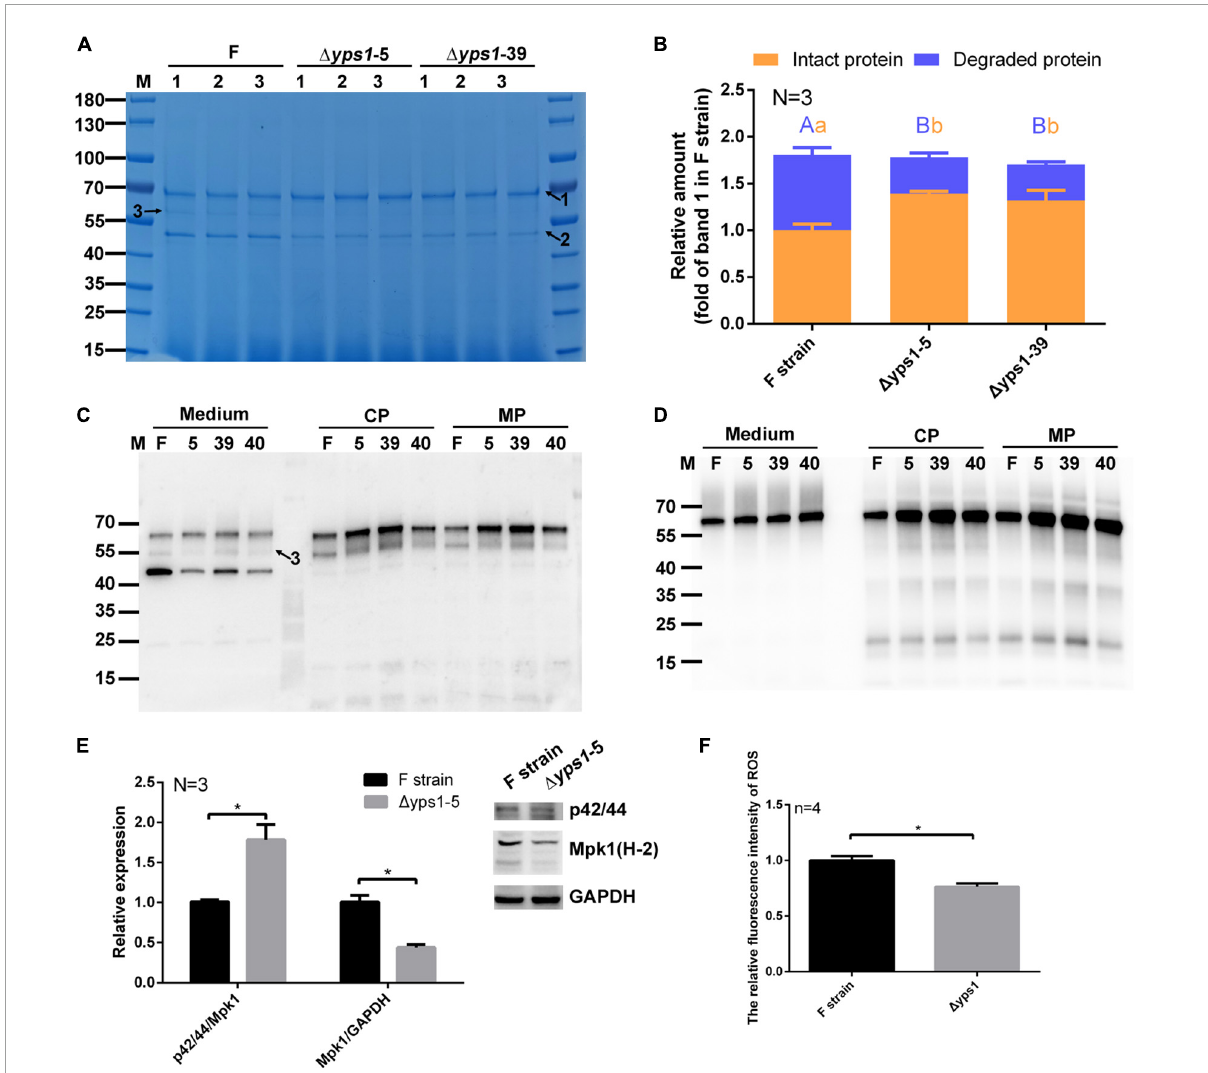
FIGURE3 SDS-PAGE and Western blot analysis of HSA-pFSH β protein in culture medium or cell of (cid:49) yps1 strains. (A) SDS-PAGE analysis of recombinant HSA-pFSH β protein in the culture medium. F, (cid:49) yps1-5 and (cid:49) yps1-39 represent the culture medium of F, (cid:49) yps1-5 and (cid:49) yps1-39 strains induced for 72 h. Numbers 1, 2 and 3 below the horizontal line represent three replicate samples of the same strain. Arrow 1, HSA-pFSH β protein; arrow 2, HSA truncated fragment; arrow 3, degraded fragment of HSA-pFSH β . (B) The relative amounts of recombinant protein in figure. The values were normalized to the intact HSA-pFSH β protein band (indicated by arrow 1) in the culture medium of F strain. Three repeats were used for data quantification. The same letters (a, b for intact protein and A, B for degraded protein) indicate no significant difference between the wild-type strain and YPS1 -disrupted strain, and different letters indicate statistically significant differences ( p < 0.05). (C,D) Western blot analysis of HSA-pFSH β protein in the culture medium or cells (including cytosolic and membrane-associated proteins) reacted with mouse 6 × His tag monoclonal antibody (C) and human FSH β monoclonal antibody (D) . CP, cytosolic protein; MP, membrane-associated protein. (E) Blots were probed with antibodies specific for phosphorylated forms of Mpk1 and Mpk1. The data shown are representative of three independent experiments. The results presented in the histogram reflect the fold-change in Mpk1 phosphorylation and Mpk1 in YPS1 mutant compared with that of the wild-type cells, based on band density in arbitrary units as quantified by densitometry analysis. (F) ROS level within F and (cid:49) yps1 strains after 72 h induction. p values were calculated using Student’s t -test with p < 0.05 considered statistically significant (marked with *). Error bars represent means ± standard deviation (SD) ( n =